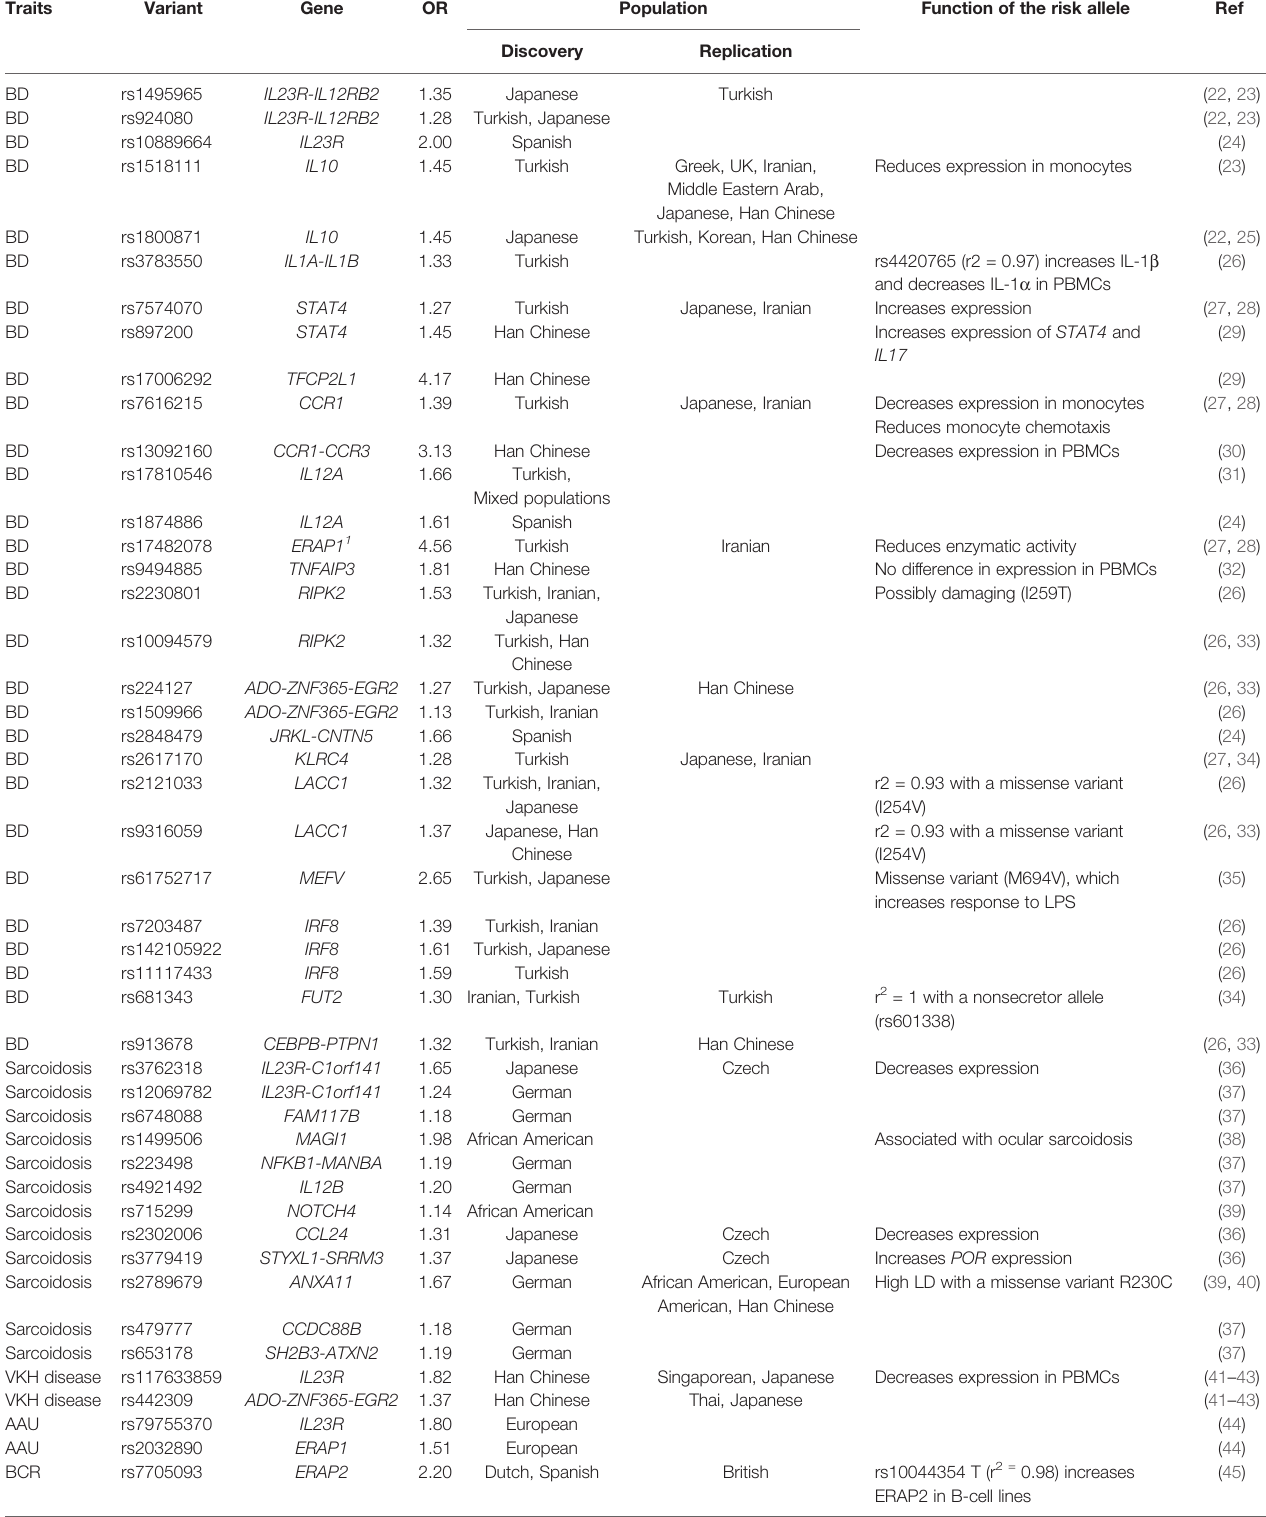
TABLE 1 | Summary of susceptibility SNPs with genome-wide signi fi cance for non-infectious uveitis. Traits Variant Gene